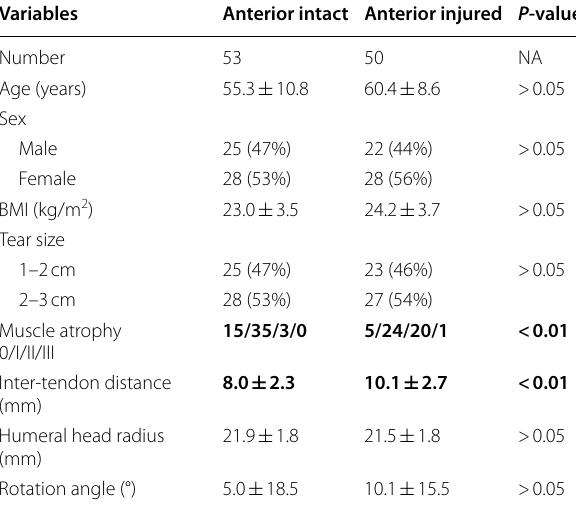
Table 1 Demographic information and magnetic resonance imaging measurement